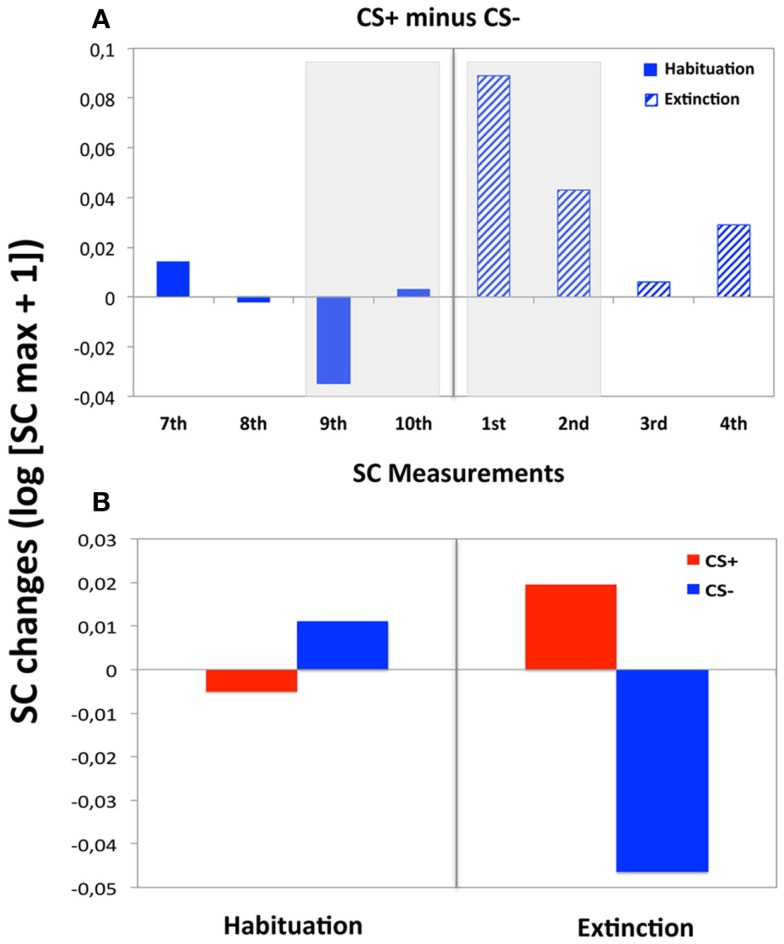
Electrodermal reactivity during habituation and extinction. (A) SC changes showing the electrodermal CS+/CS− differentiation across tested SC measurements in pre- and post-learning phases. In solid, dark blue, the last four SC measurements in habituation phase; in dashed, light blue the first four SC measurements during extinction trials. (B) Averaged electrodermal activity for the CS− and CS+, over the SC measurements selected for the repeated measures ANOVA described in this section (i.e., the last two SC measurements during habituation trials and the first two SC measurements during extinction).